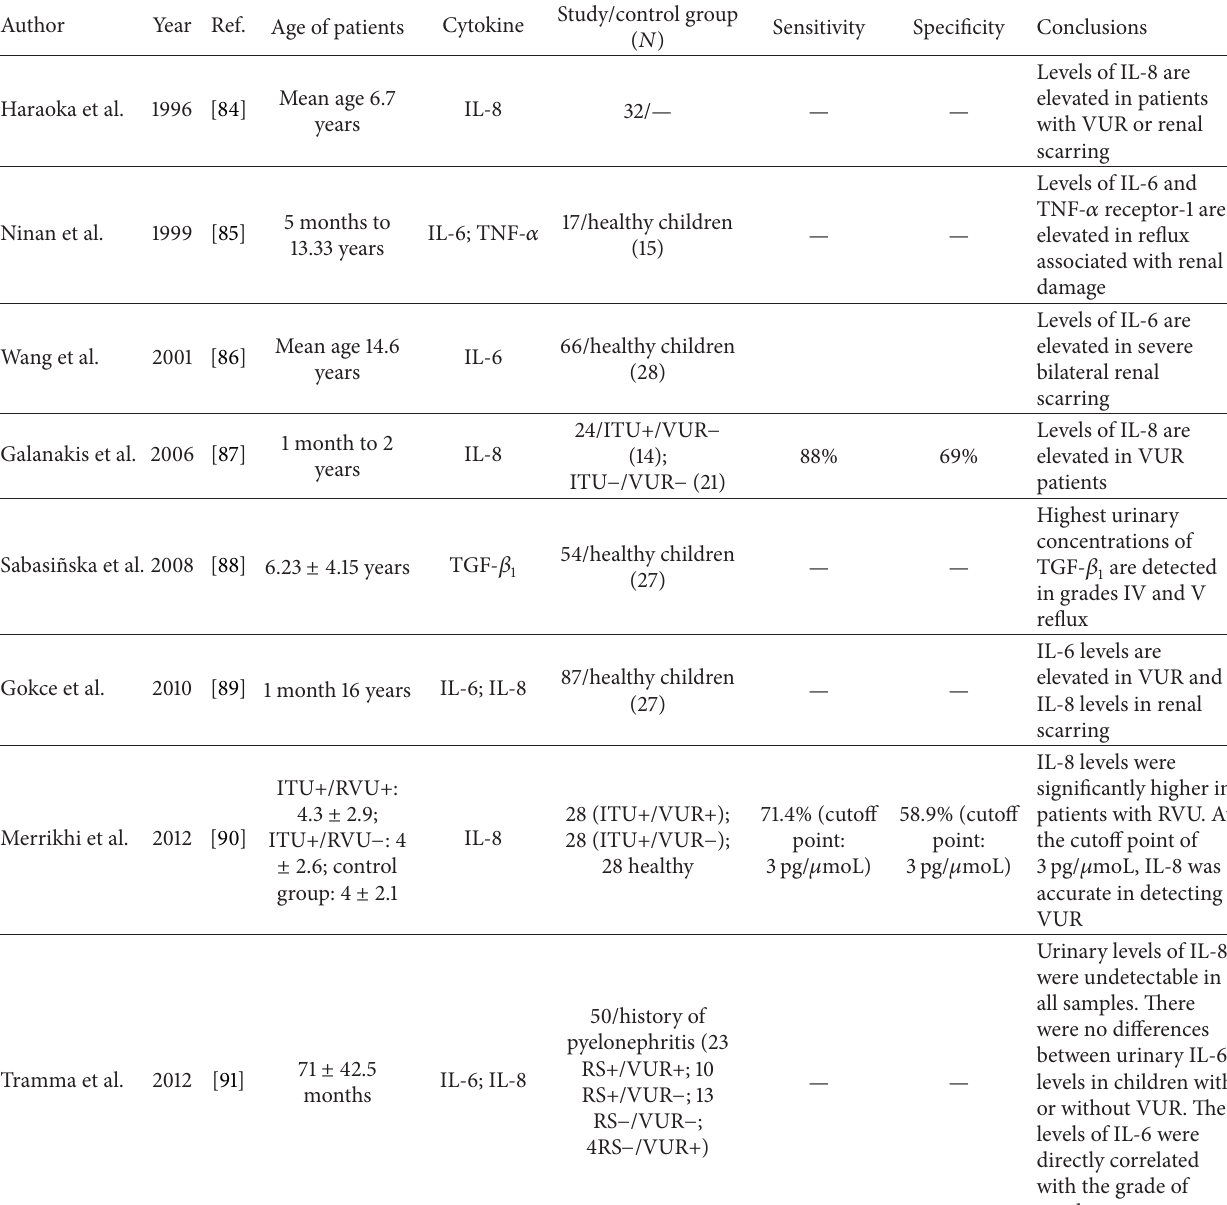
Table 2: Studies on urinary cytokines in patients with vesicoureteral reflux